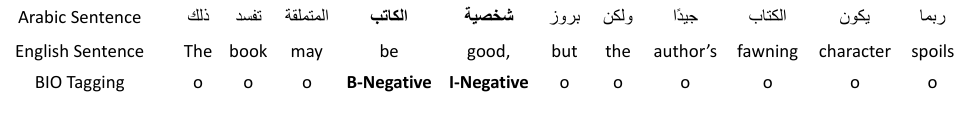
Figure 4. First type of error. Second example.